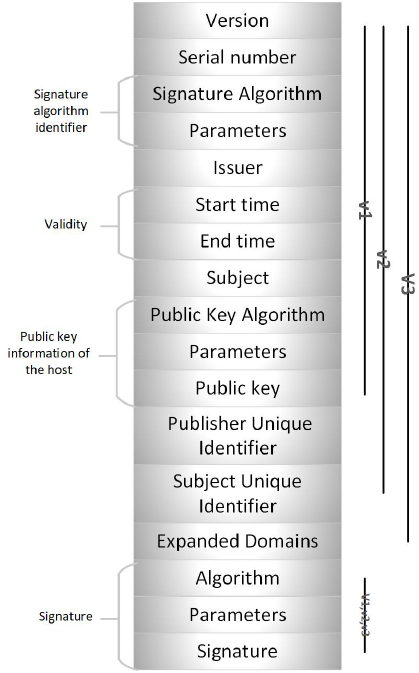
Figure 1. X.509 certificate